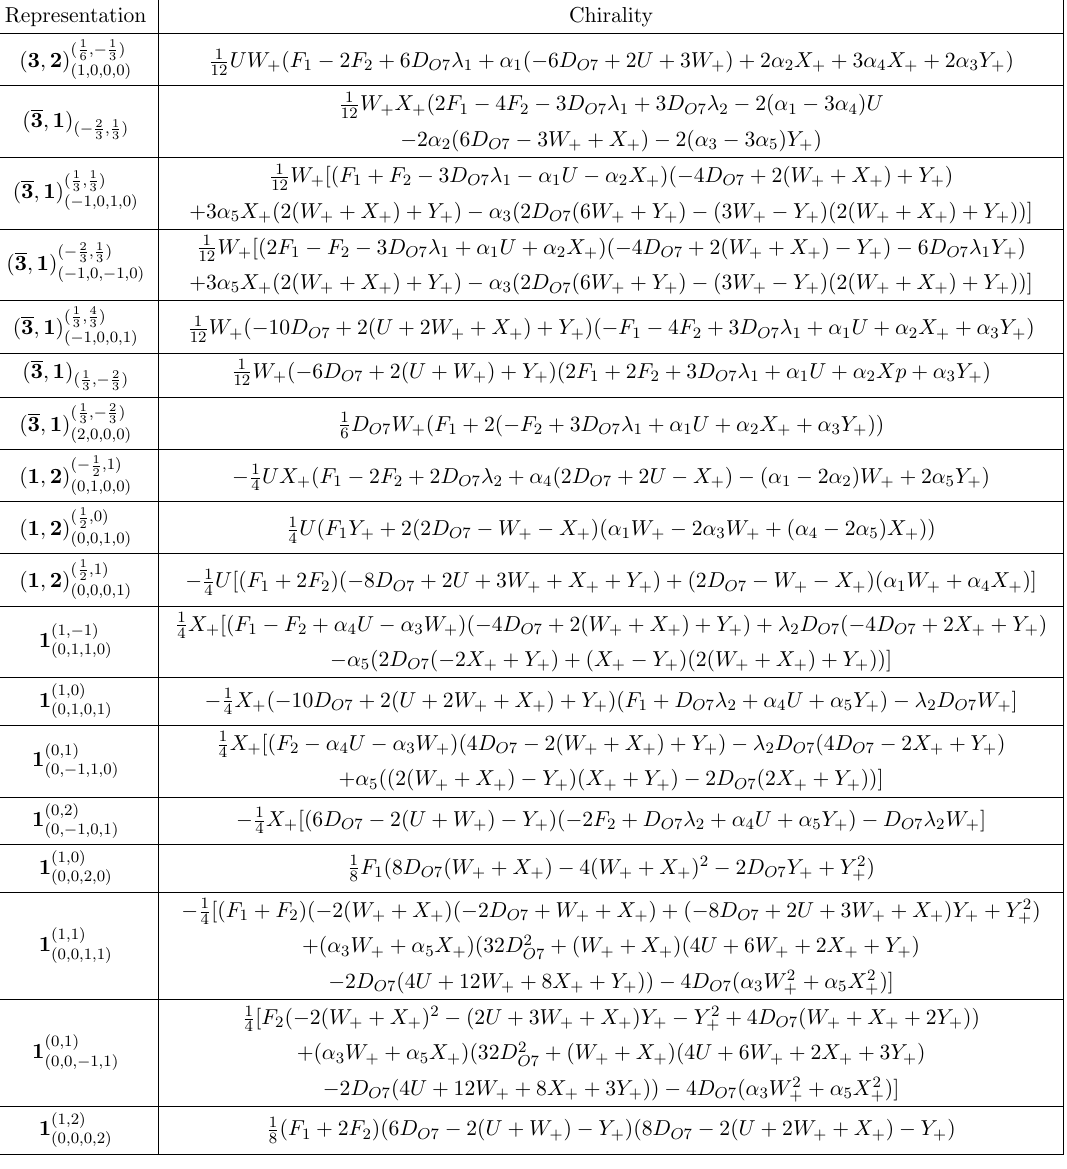
Table 15 . Chiral Indices for the matter in type IIB limit of the SU(3) (cid:2) SU(2) (cid:2) U(1) 2